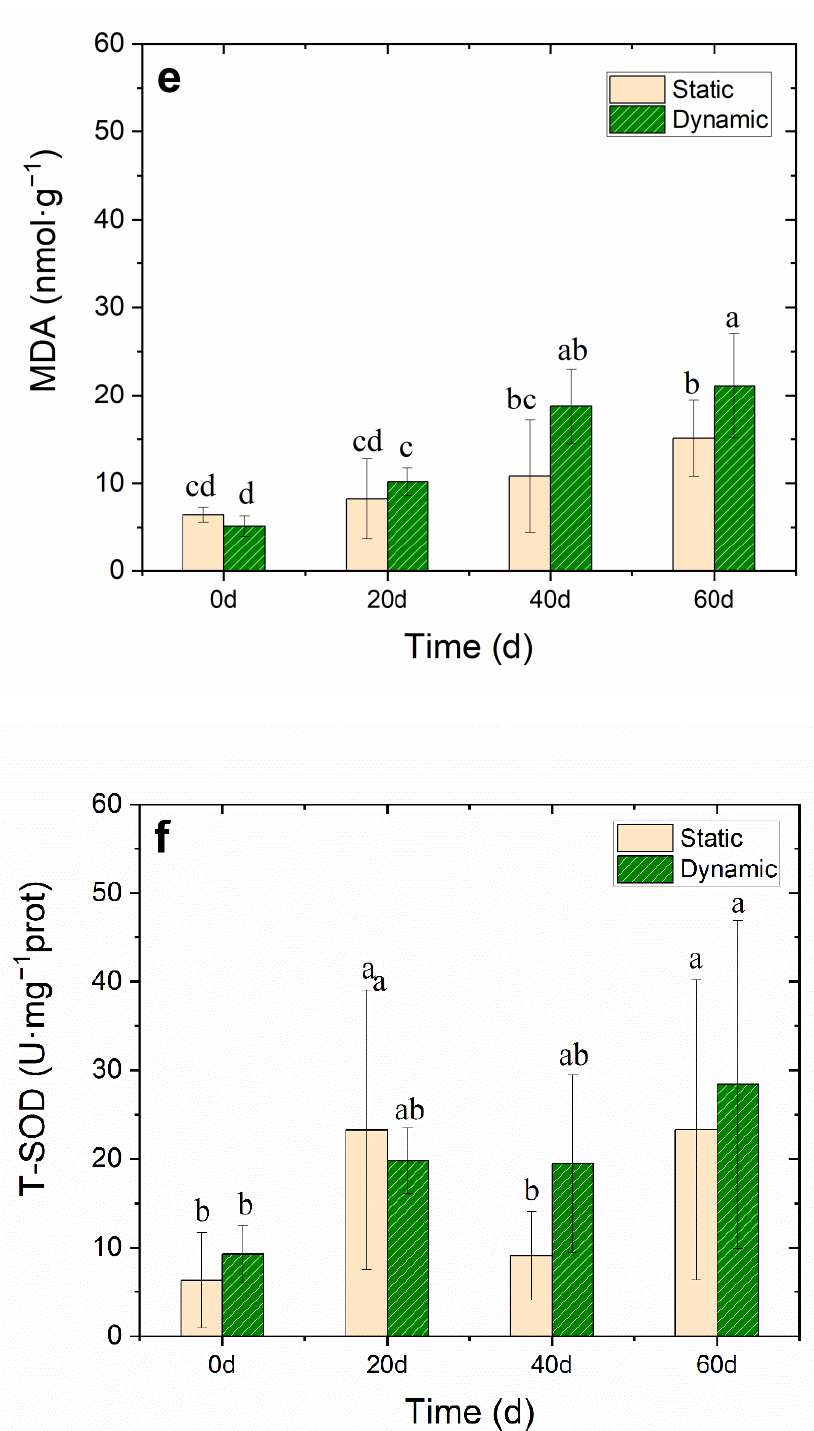
Figure 4. Effects of water flow on ( a ) total chlorophyll (mg · g − 1 , FW), ( b ) soluble sugar (mg · g − 1 prot), ( c ) total protein (mgprot · g − 1 , DW), ( d ) root activity ( µ g · g − 1 · h − 1 , FW), ( e ) MDA (nmol · g − 1 , DW) and ( f ) T-SOD activity (U · mg − 1 prot) of V. natans during the 60-day cultivation period. All data had a mean value ± SD. The lowercase letters above the ivory static bars and green dynamic bars indicate significant differences ( p < 0.05) among different treatments.